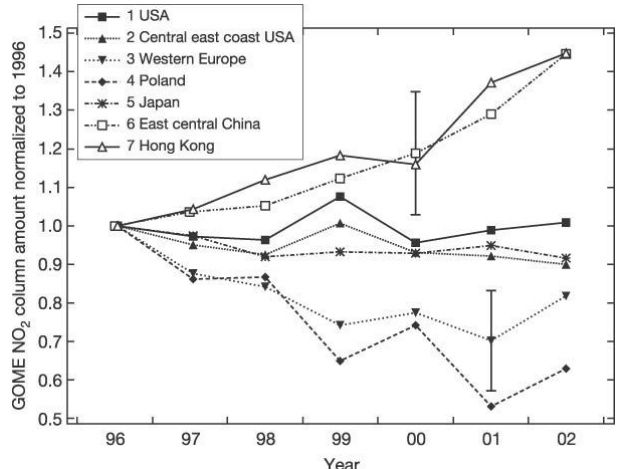
Figure 17. The mean annual NO 2 column amount normalized to that in 1996 for the geographical regions of the USA, the central east coast of the USA, western Europe, Poland, Japan, eastern central China and Hong Kong, showing a marked increase in NO 2 over China and a decrease over Europe (Richter et al.,